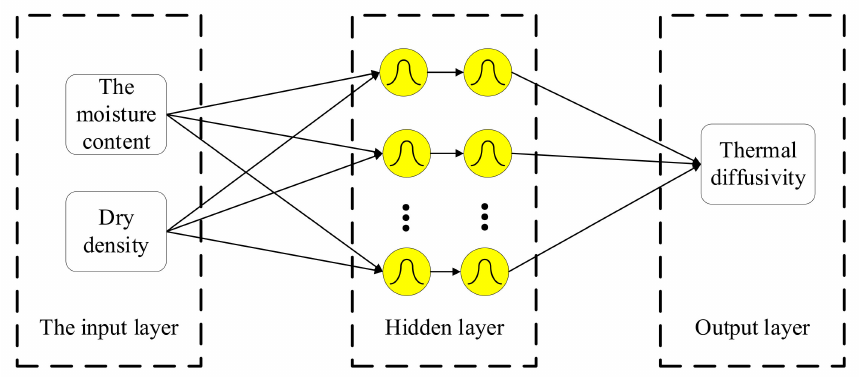
Figure 11. RBF neural network structure